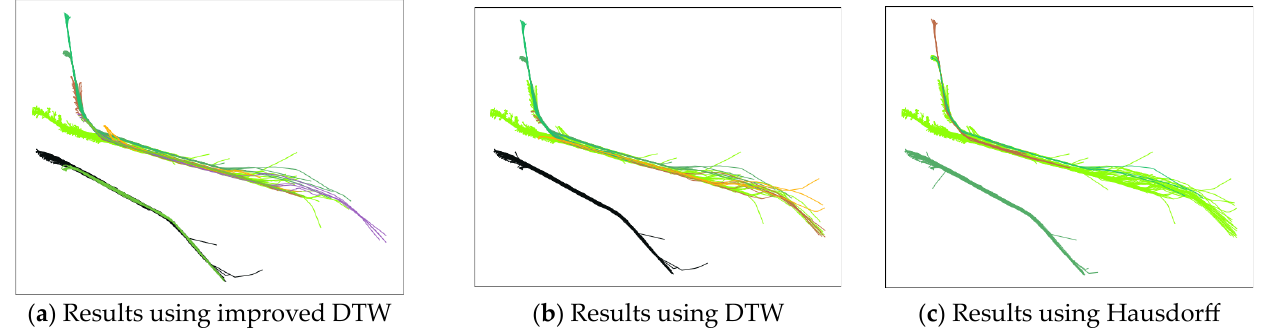
Figure 16. Clustering effect comparison based on three trajectory similarity measurement methods. Table 6. DBSCAN clustering results of different trajectory similarity measurement methods.